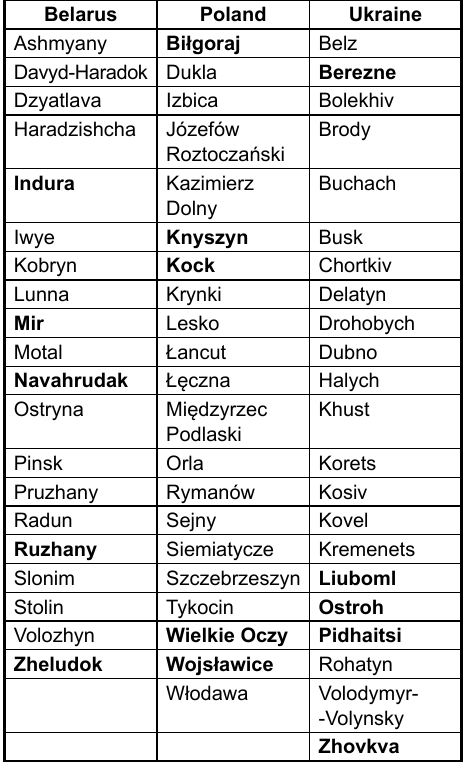
Tab. 1. List of towns selected for Shtetl Routes . Towns with thicked names were selected for 3D modelling Belarus